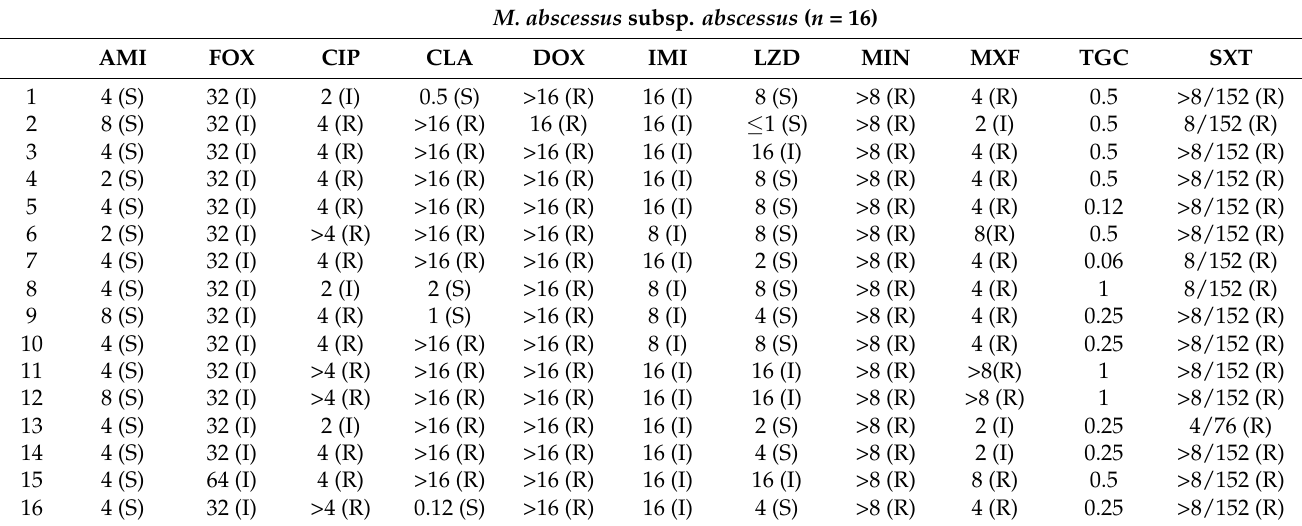
Table 5. Results of in vitro susceptibility testing for M. abscessus subsp. abscessus